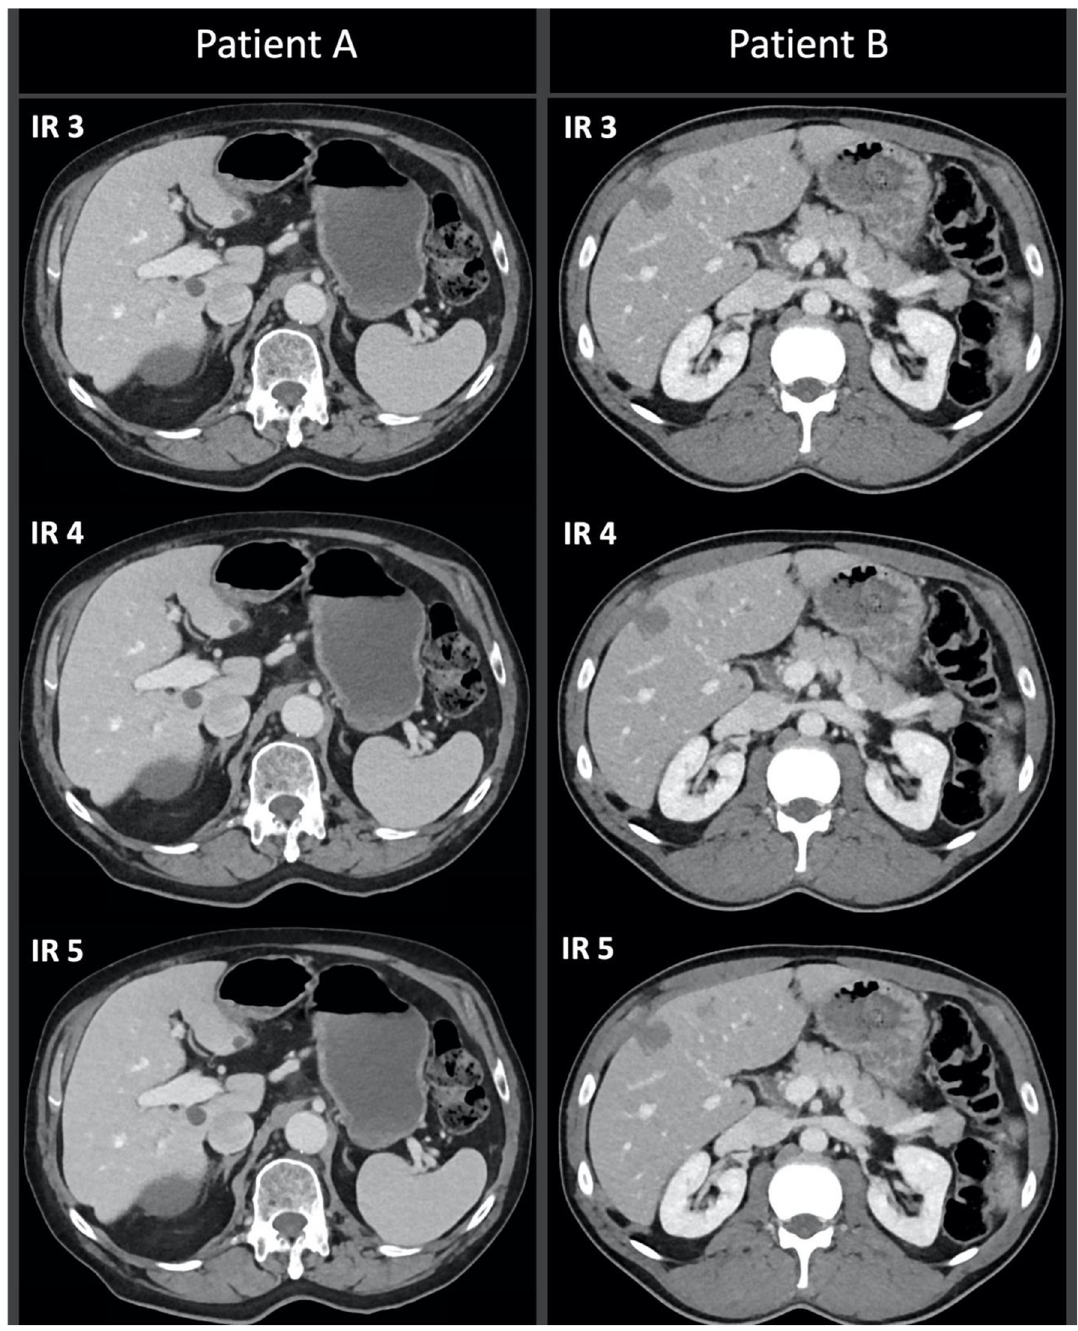
Fig 2. Abdominal scan of an 86-year-old patient (Patient A) in the follow-up for a urothelial cell carcinoma, who has multiple cysts in the liver parenchyma. In addition, a scan of a 47-year-old male (Patient B) in the follow-up for hepatic metastasis of colorectal cancer. Both scans are reconstructed with IR strength 3, 4 and 5. The scans reconstructed with IR 4 were rated in consensus to have the best lesion detection capability.